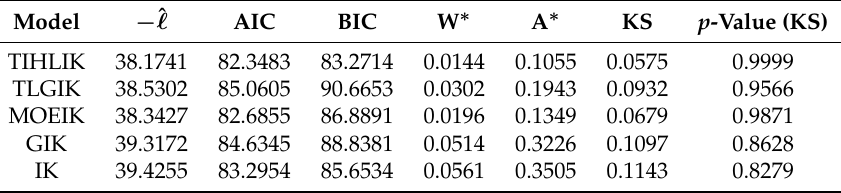
Table 9. The − ˆ (cid:96) , AIC , BIC, W ∗ , A ∗ , KS, and p -value values for data set